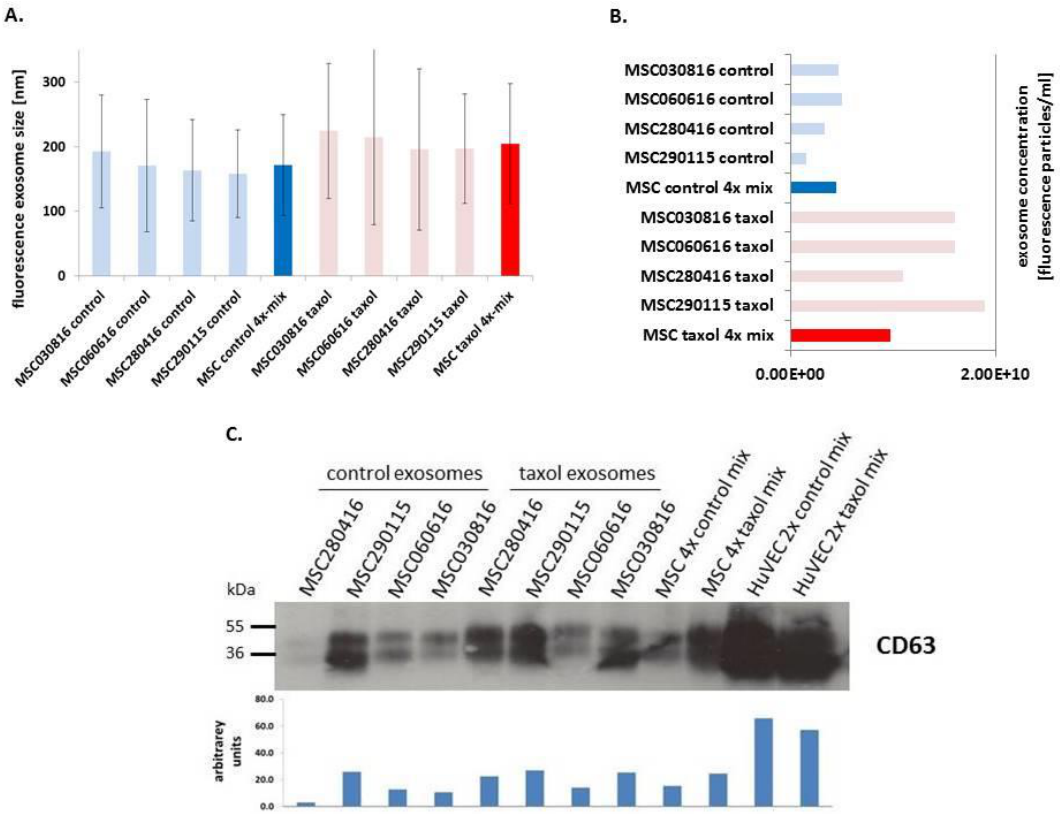
Figure 2. Characterization of isolated exosomes by nanoparticle tracking analysis (NTA) was performed in fluorescence mode of the ZetaView PMX120 by measurement of ( A ) fluorescence particle size and ( B ) the amount of fluorescence particles from the four di ff erent MSC cultures (light blue bars), a mixture of the four MSC exosomes (blue bars), the four di ff erent MSC cultures after treatment with 10 µ M taxol for 24 h (light red bars), and a mixture of the four MSC-derived fluorescence particles after treatment with 10 µ M taxol for 24 h (red bars), respectively. ( C ) Immunoblot analysis (upper panel) was performed for the presence of tetraspanins (CD63) in the various di ff erent MSC exosome preparations in the absence and presence of taxol as indicated, a mixture of two di ff erent HuVEC control exosome preparations, and a particle mixture of these two HuVEC cultures after treatment with 10 µ M taxol for 24 h. Intensities of the appropriate expression levels (lower panel) were quantified using the ImageJ software. The corresponding original blot is documented in Supplementary Materials Figure S5.